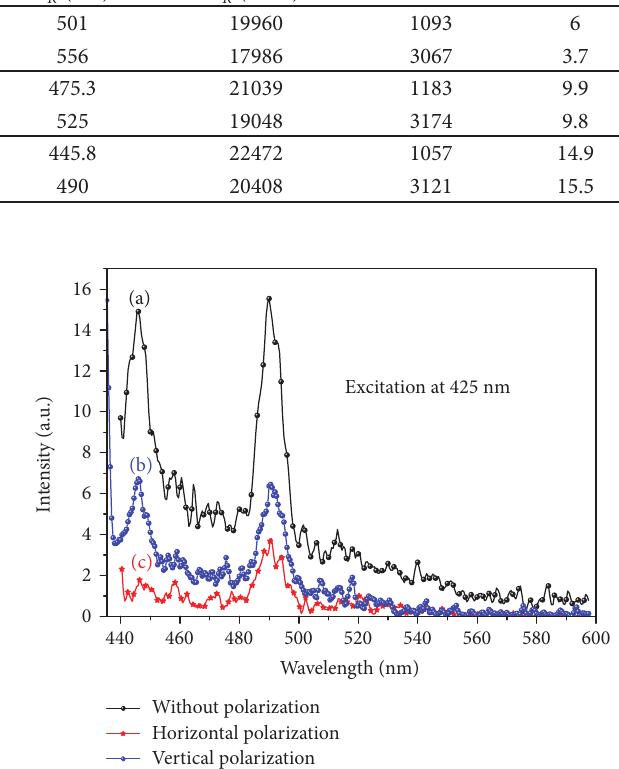
Figure 10: Polarized Raman spectra for